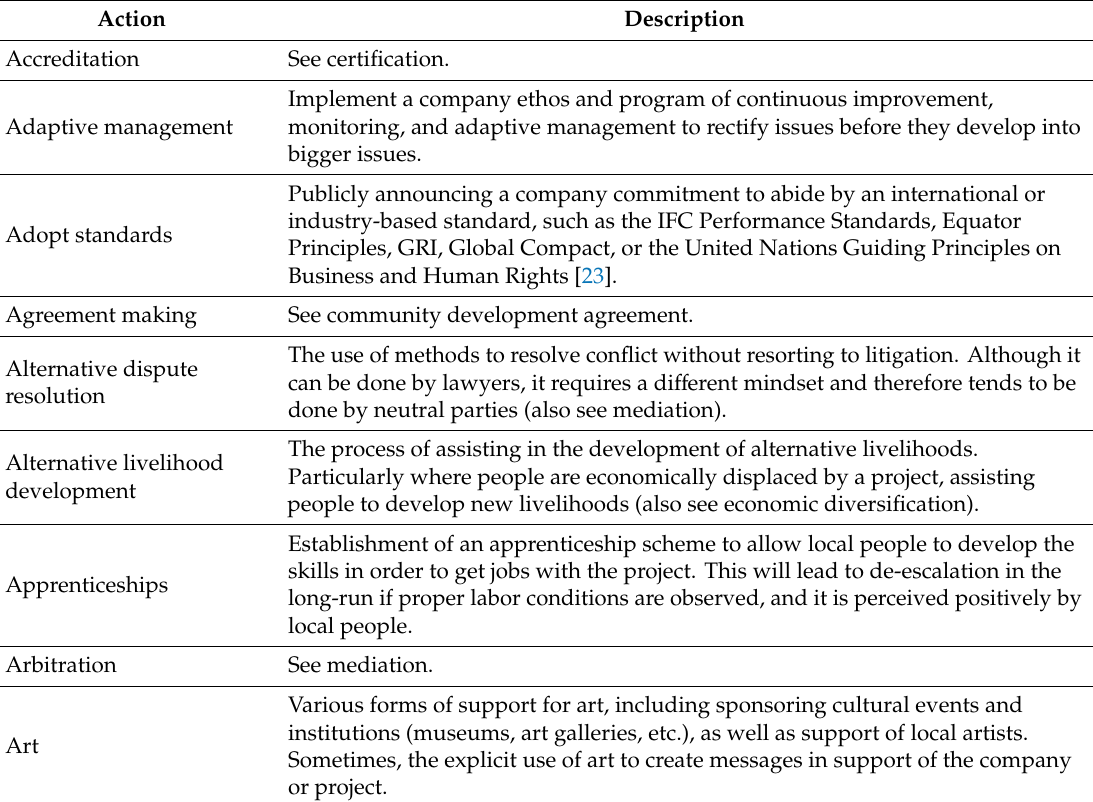
Table 1. Company actions likely to lead to de-escalation of